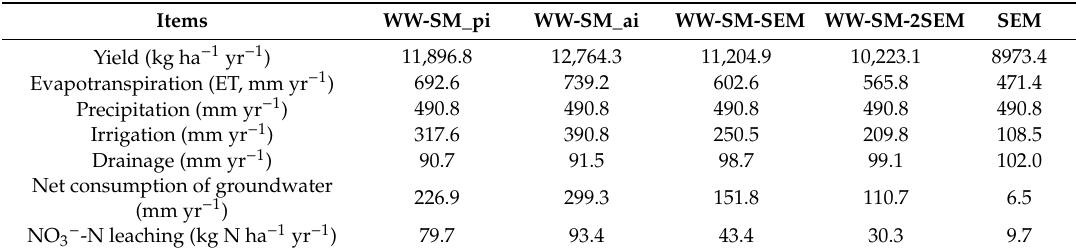
Table 5. The simulated average of yields, water balance, and NO 3 − -N leaching under di ff erent cropping systems over the past 30 years (1985-2015).